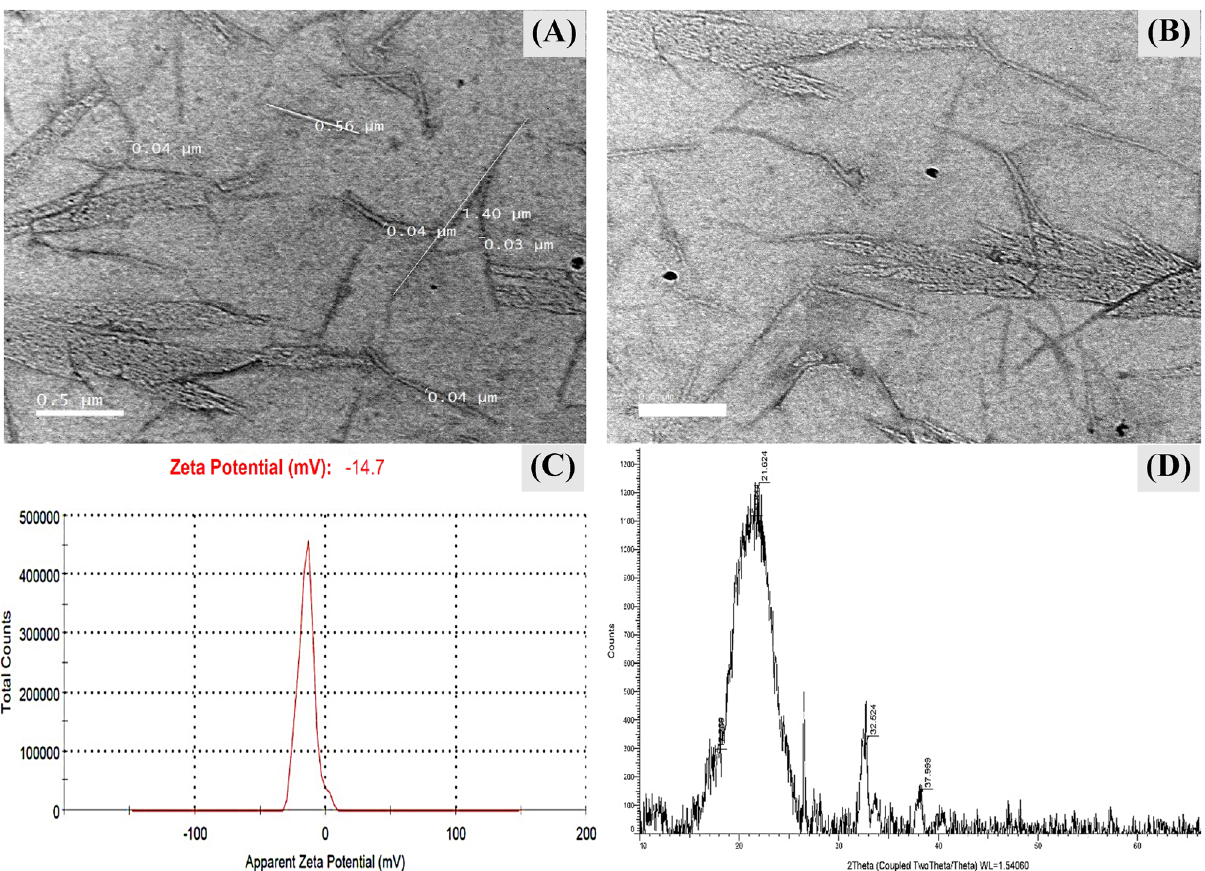
Figure 5. ( A , B ) Transmission electron microscopy morphology of bacterial nanocellulose sample, ( C ) Zeta potential, ( D ) X-ray diffraction of Bacillus sp . strain